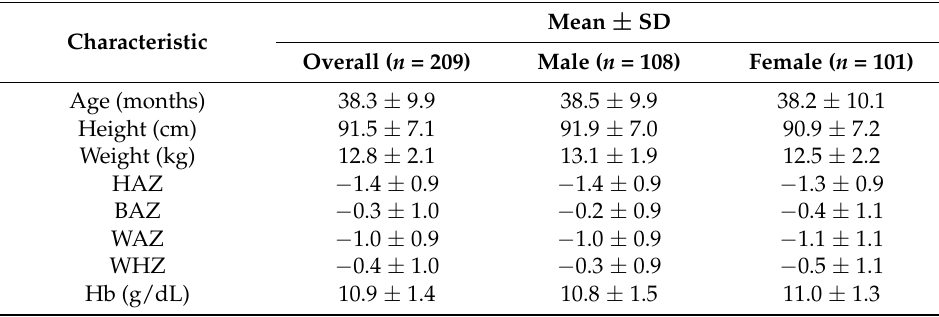
Table 1. Demographic characteristics of the 209 children enrolled.